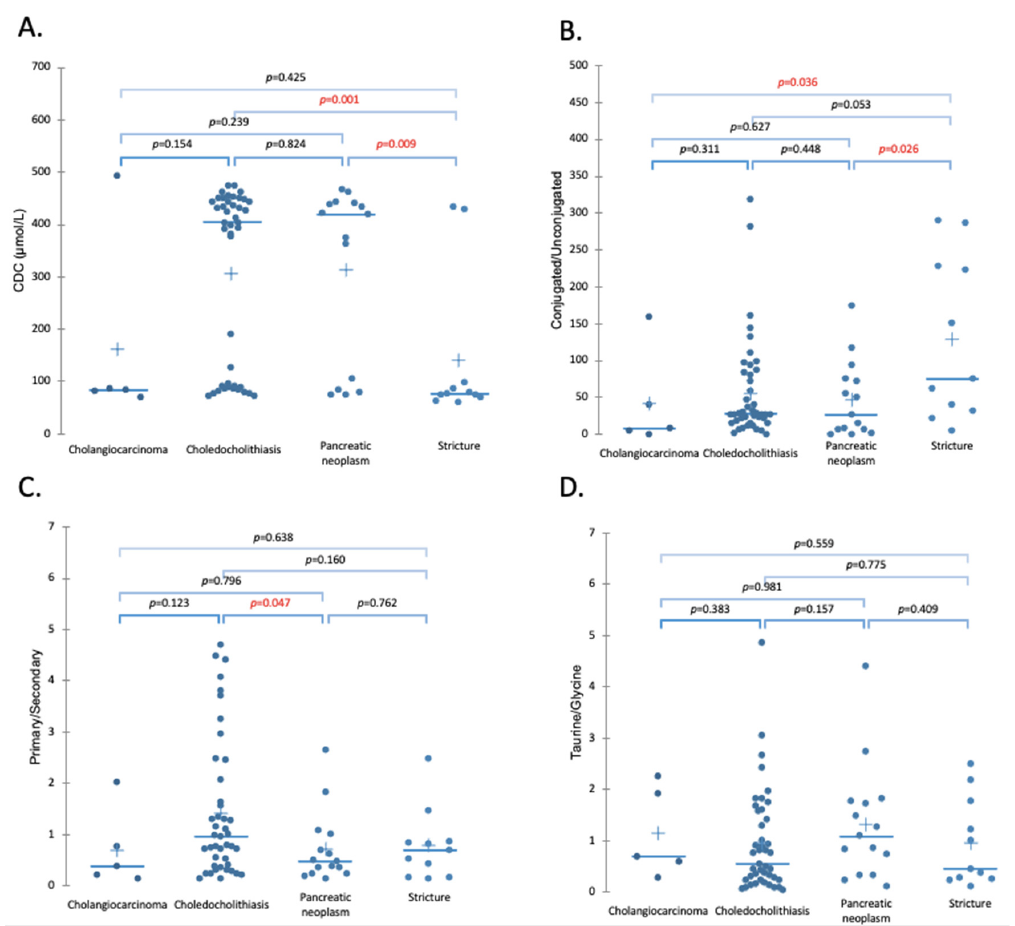
Figure 3. ( A ). Changes of CDC with respect to disease type. The statistical difference between strictures and pancreatic neoplasms as well as choledocholithiasis was indicated. Concentrations of CDC are altered with the development of gallstones and pancreatic cancer. ( B) . Conjugated/unconjugated ratios of BSs in patients with different malignancies. Elevated ratios indicate increasing conjugated forms of the BSs and simultaneous depletion of unconjugated forms. ( C) . Primary/secondary ratios of BSs. The ratios were most influenced by the presence of biliary stones. ( D ). Taurine/glycine ratios do not show any changes with disease types.